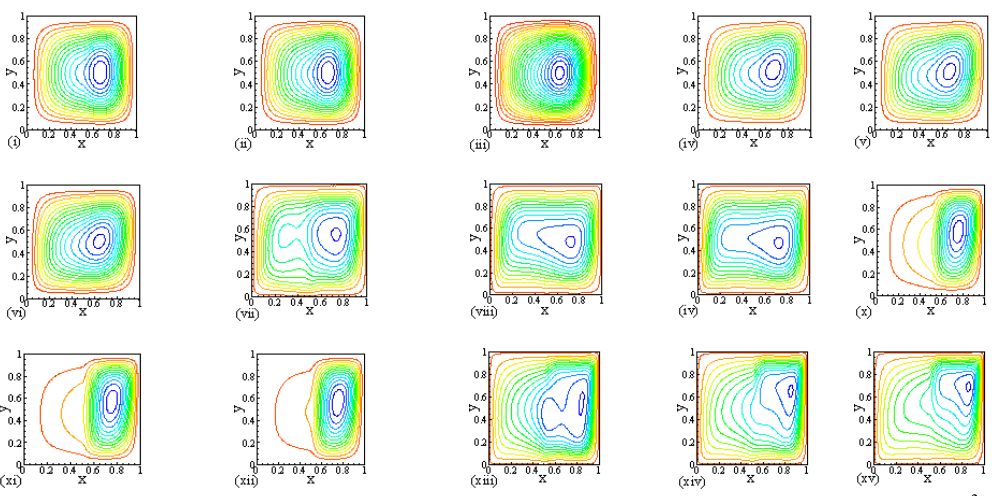
Fig. 4 (b). Streamlines of vertical porous layer at (i)  =0.4 (ii)  =0.6 (iii)  =0.9 while Ra = 10 3 , Da = 10 -2 , (iv)  =0.4 (v)  =0.6 (vi)  =0.9 while Ra = 10 4 , Da = 10 -2 , (vii)  =0.4 (viii)  =0.6 (ix)  =0.9 while Ra = 10 5 , Da = 10 -2 , (x)  =0.4 (xi)  =0.6 (xii)  =0.9 while Ra = 10 5 , Da = 10 -4 and (xiii)  =0.4 (xiv)  =0.6 (xv)  =0.9 while Ra = 10 6 , Da = 10 -4 .